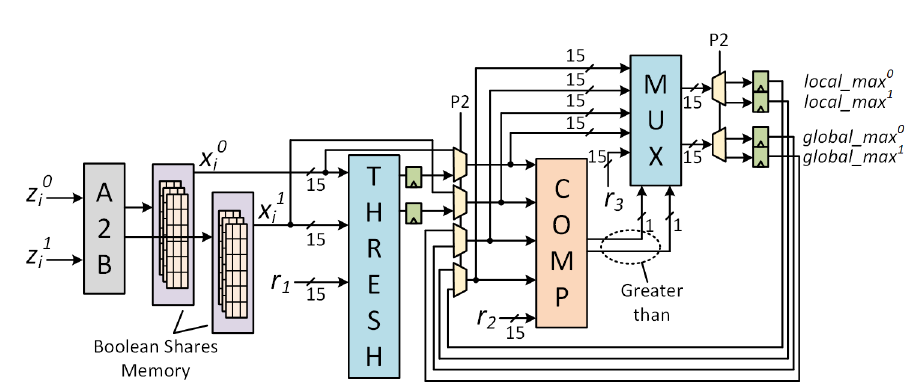
Figure 11: Hardware design of the fully masked output layer. Figure is not to